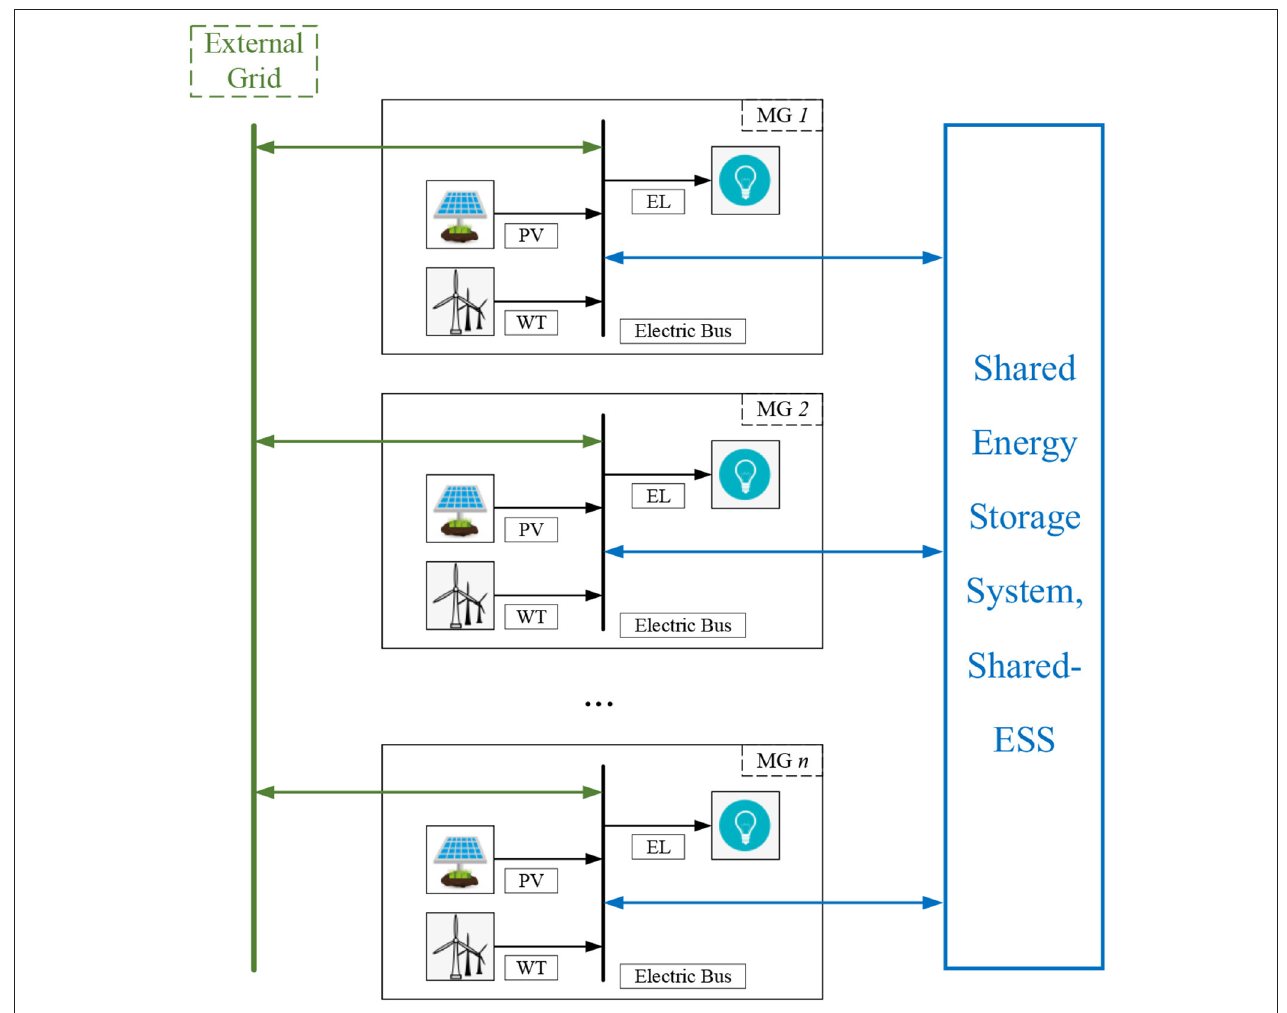
FIGURE 1 | The general infrastructure of microgrid cluster with